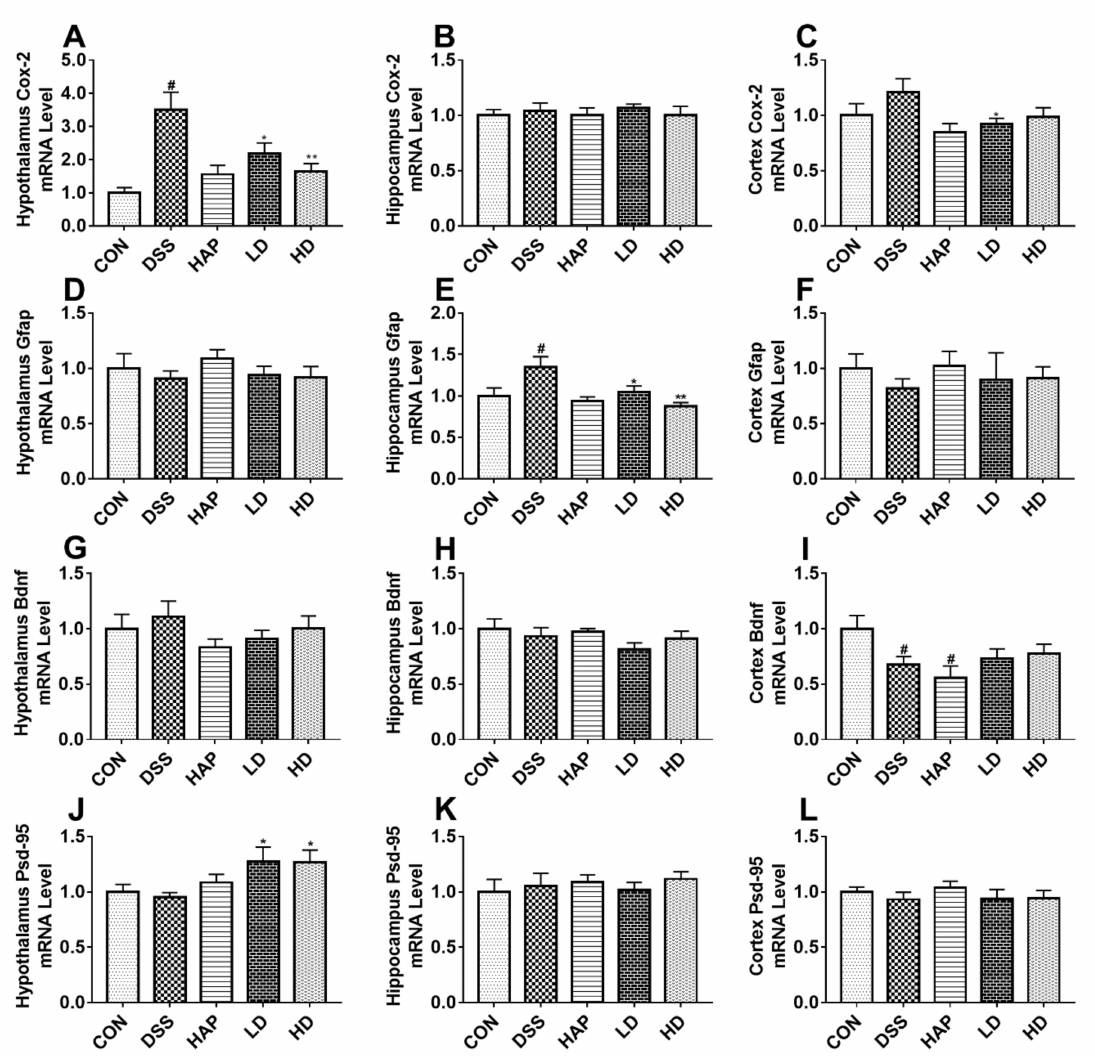
Figure 8. Effect of APE on acute UC-related neuroinflammation and synapse damage: The mRNA levels of cyclooxygenase-2 ( Cox-2 ) in hypothalamus ( A ), hippocampus ( B ), and cortex ( C ). The mRNA levels of glial fibrillary acidic protein ( Gfap ) in hypothalamus ( D ), hippocampus ( E ), and cortex ( F ). The mRNA levels of brain derived neurotrophic factor ( Bdnf ) in hypothalamus ( G ), hippocampus ( H ), and cortex ( I ). The mRNA levels of postsynaptic-density protein 95 ( Psd-95 ) in hypothalamus ( J ), hippocampus ( K ), and cortex ( L ). n = 8 or 9. # p < 0.05 vs. CON group. * p < 0.05 vs. DSS group. ** p < 0.01 vs. DSS